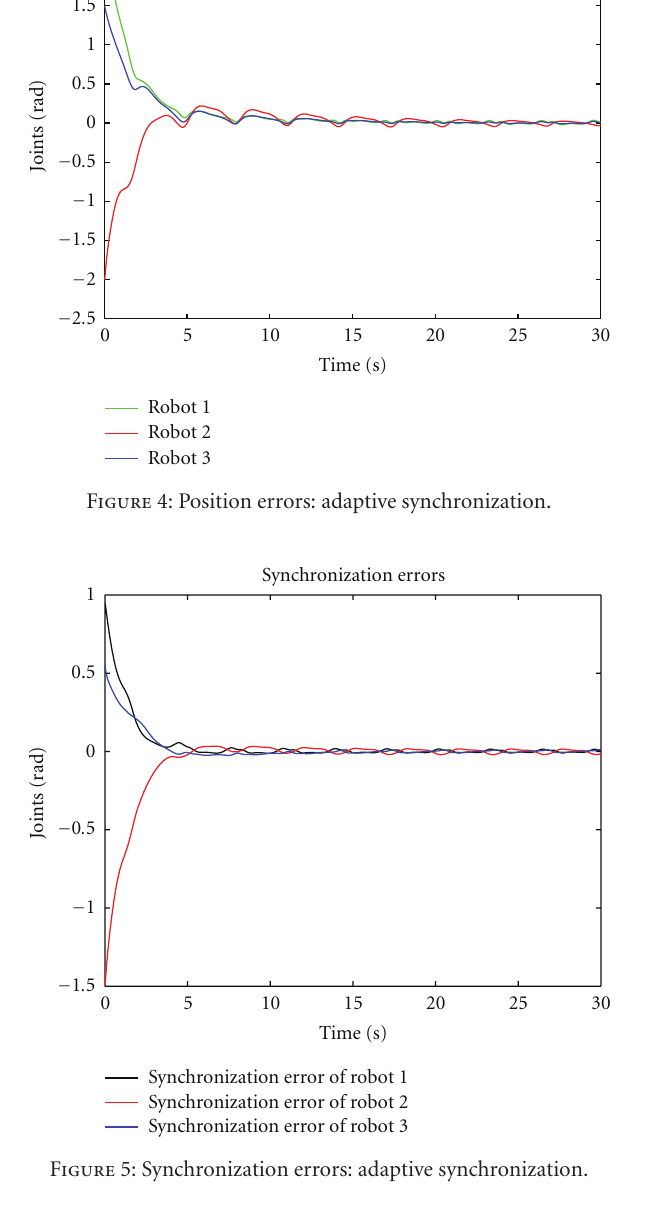
Figure 7: Robots synchronization in presence of time